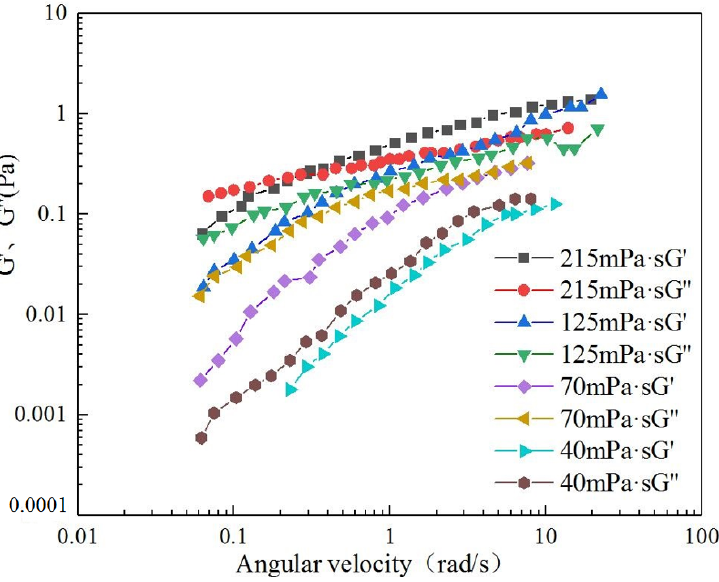
Figure 4. Changes in the storage and energy dissipation moduli of polymers with different viscosities.